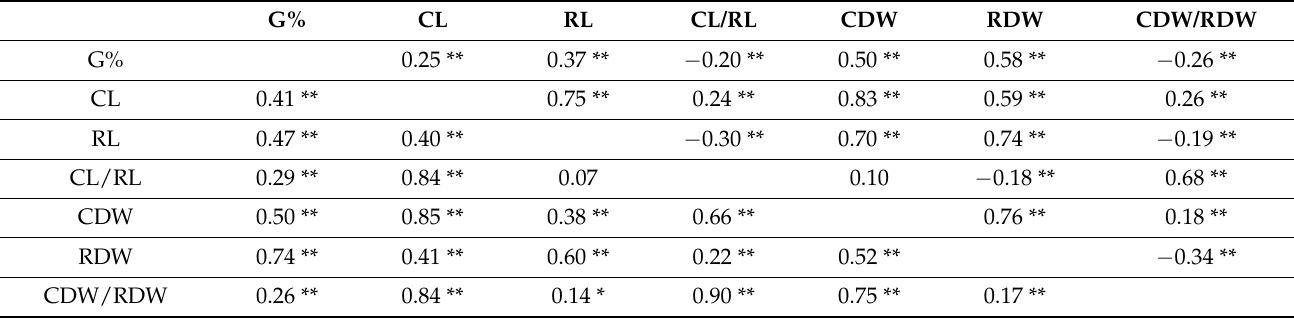
Table 2. Phenotypic correlation coefficients among germination and establishment related-traits measured in the MAGIC population evaluated under water stress (below diagonal) obtained with 200 g L − 1 of Polyethylene glycol 6000 and under well-water condition (above